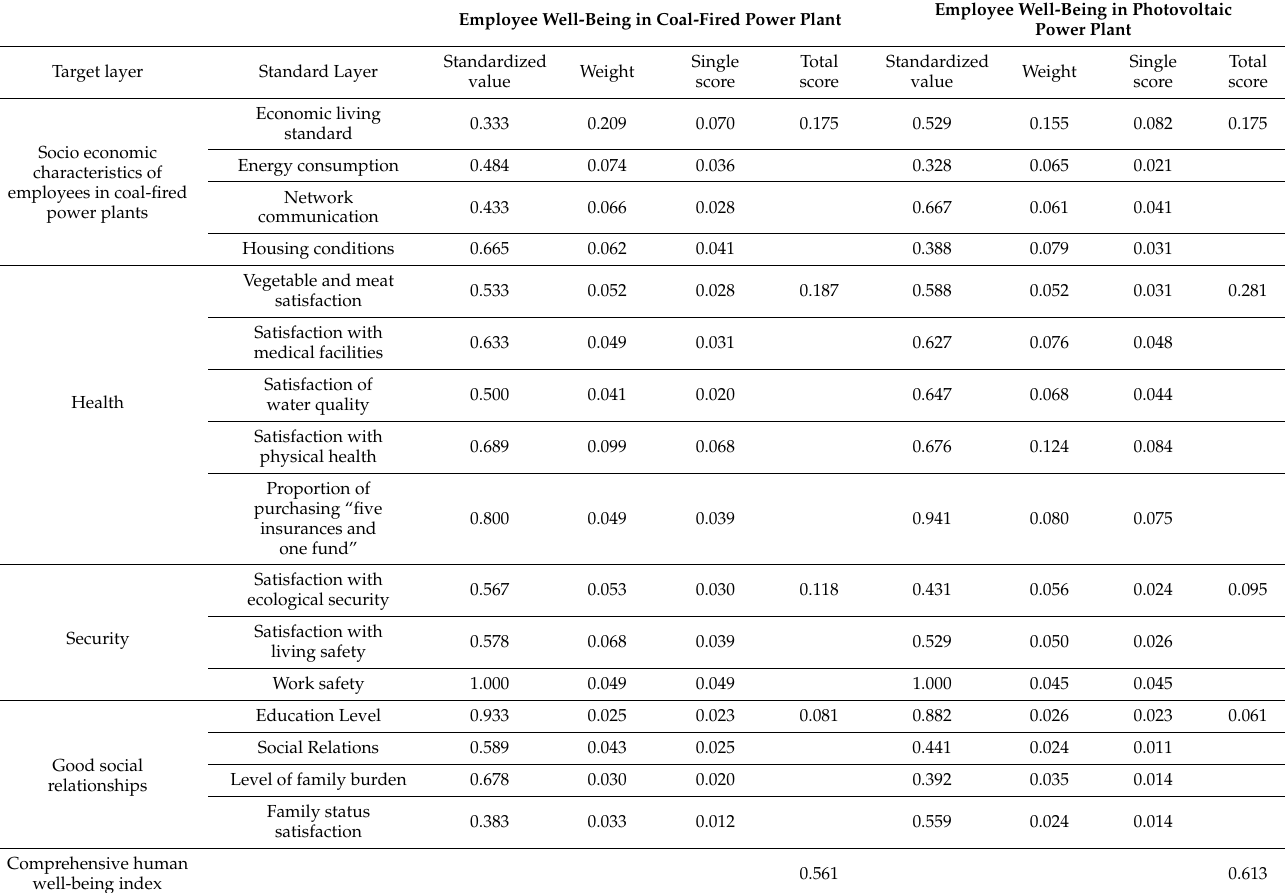
Table 10. Comparison of the comprehensive human well-being index of employees in coal-fired power plants and photovoltaic power